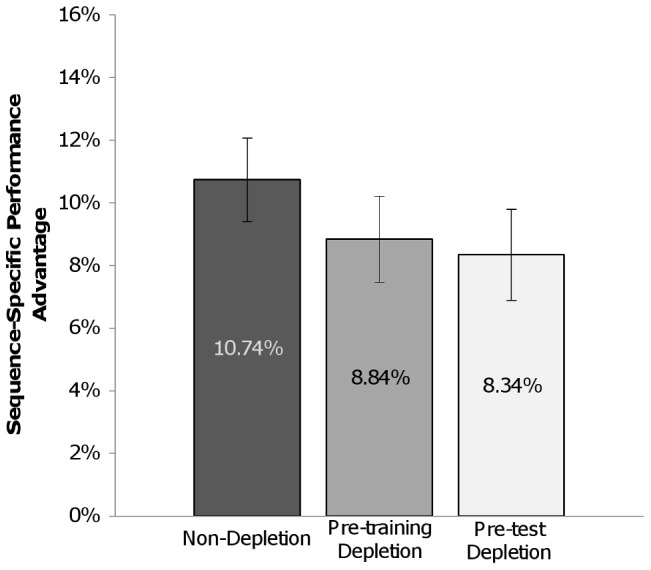
SISL test performance for Experiment 2.Participants who completed the challenging depletion task either prior to training (Pre-training Depletion) or prior to test (Pre-training Depletion) exhibited a smaller sequence-specific performance advantage at test compared to participants who had received the easy task (Non-Depletion). Error bars reflect SEM.